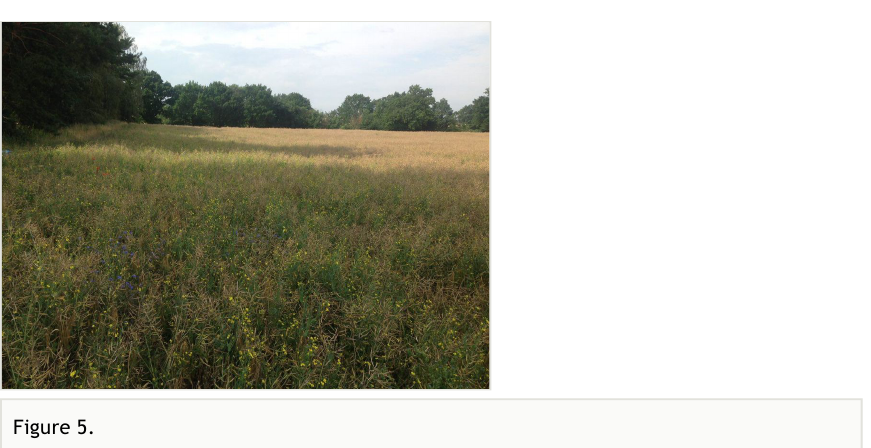
Delayed fl owering of rape in the transition zone to the forest at the west-facing site. View towards south. Picture taken in summer.